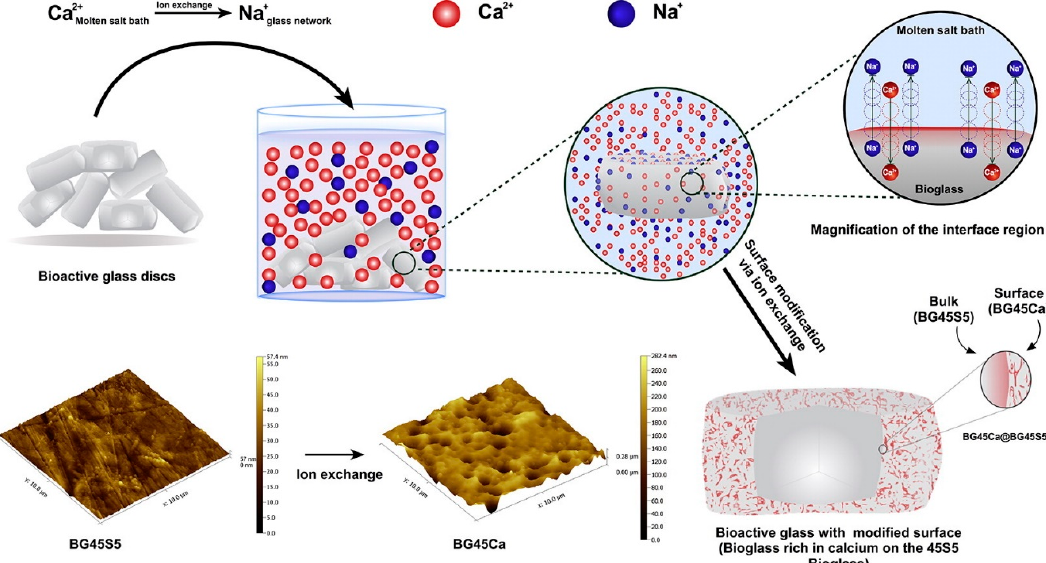
Figure 6. Schematic image of surface modification of 45S5 bioglass by ion exchange technique via immersion of the samples in a molten salt bath. Reproduced with permission from ref [63] .